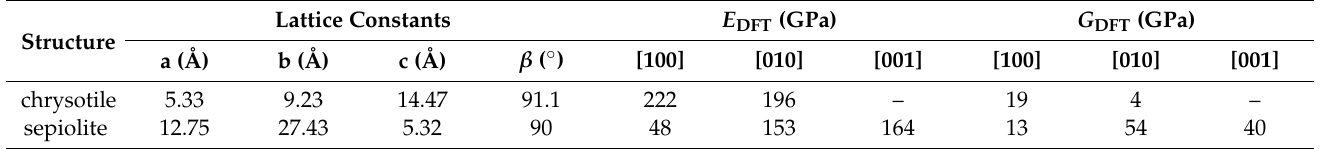
Table 1. Lattice constants, Young’s modulus, and the shear modulus along different crystallographic directions of hydrosilicates with chrysotile and sepiolite structure, determined using DFT modeling. Lattice Constants Structure